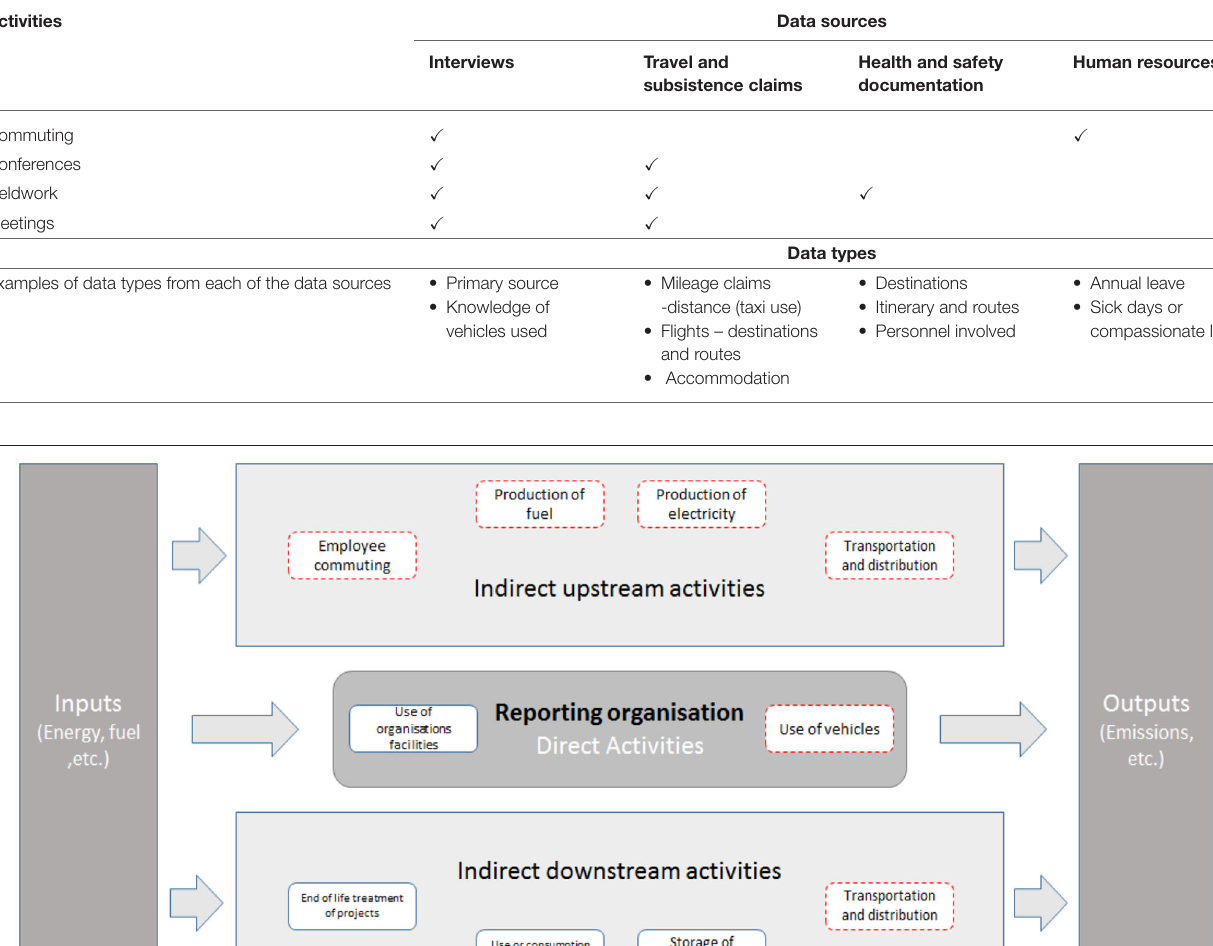
TABLE 1 | The different data sources and examples of the types of data they contributed to the LCI.